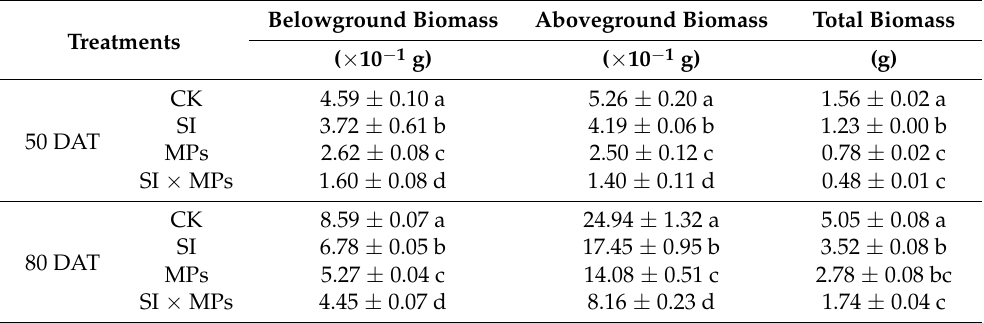
Table 1. Mean rice belowground, aboveground, and total biomass under different treatments at the 50th and 80th days after transplanting, presented as the mean ± standard error ( n = 7). Belowground Treatments